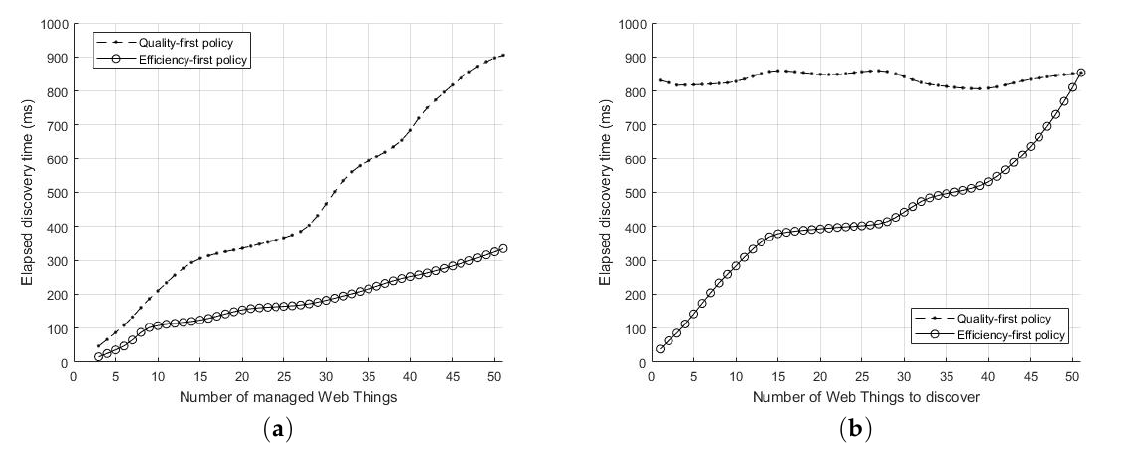
Figure 8. Elapsed time for performing service discovery based on ROSA. ( a ) Discovering 3 Web Things ( γ = 3) with different number of managed Web Things ( m ); ( b ) Discovering different number of Web Things ( γ ) while the total number of managed Web Things is fixed at 51 ( m = 51)